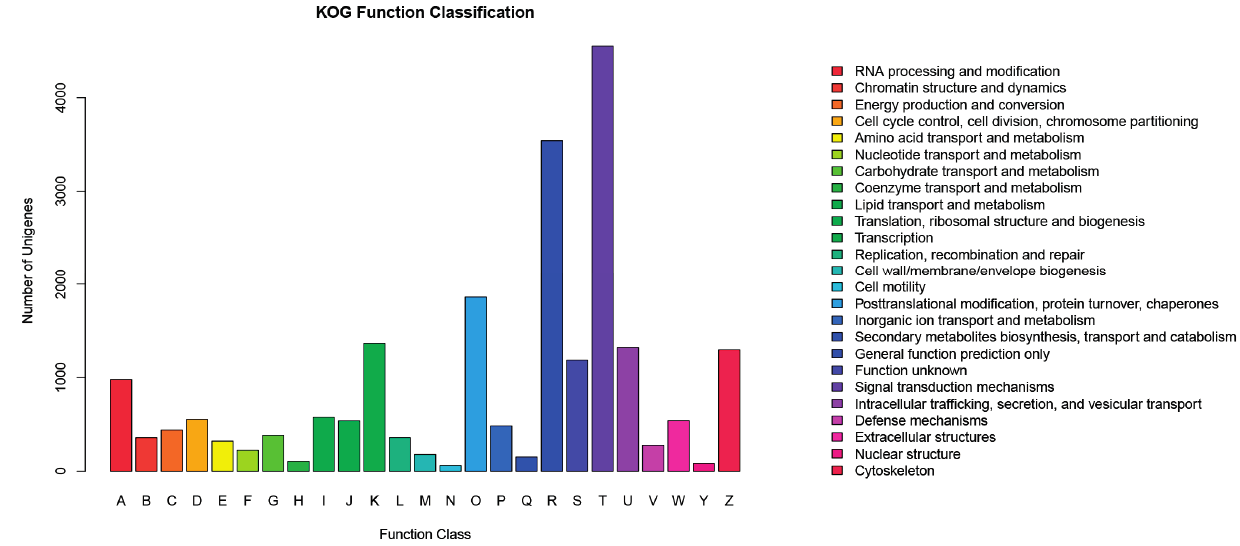
Figure 5. Histogram presentation of eukaryotic clusters of orthologous groups (KOG) classification. A total of 9534 sequences were clustered into 25 KOG